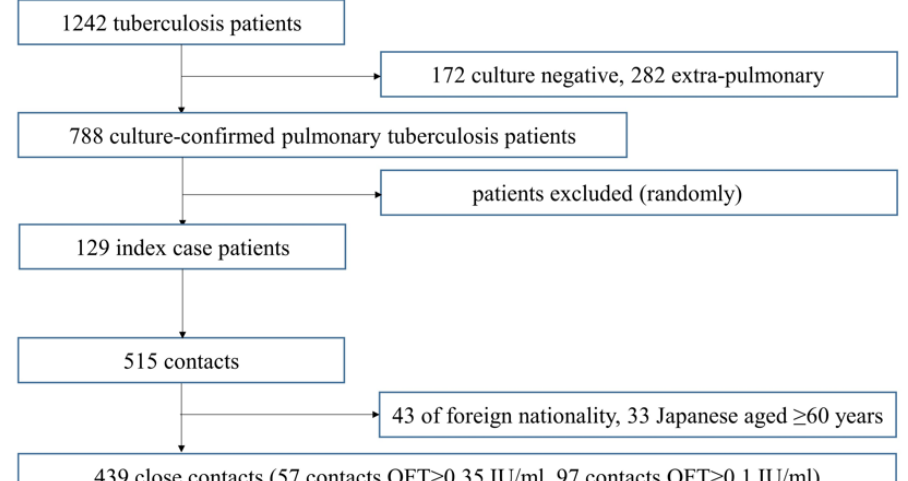
Figure 1. Flow chart of study outline.